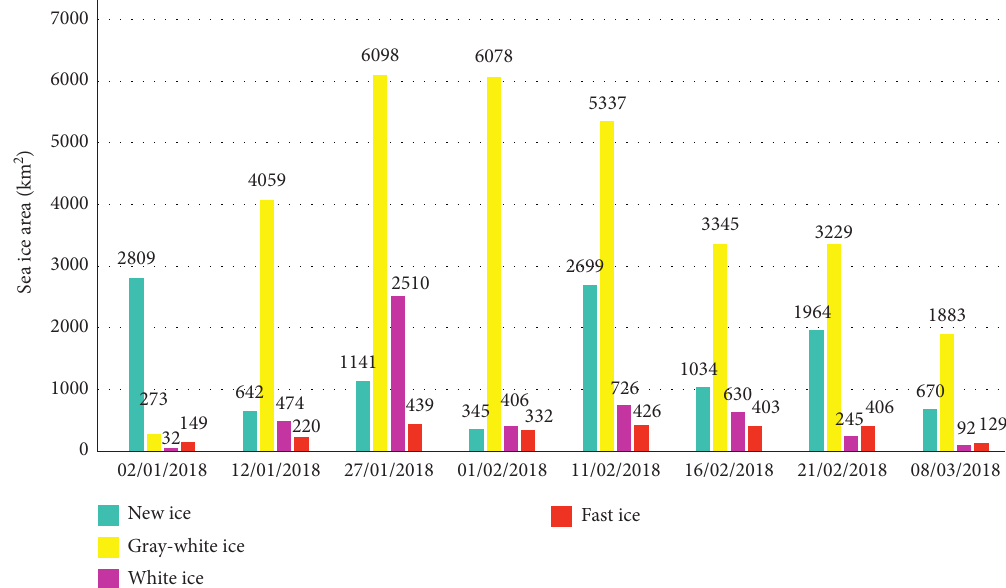
Figure 10: The area statistics of various sea ice types in Liaodong Bay during the freezing period in 2017/2018.